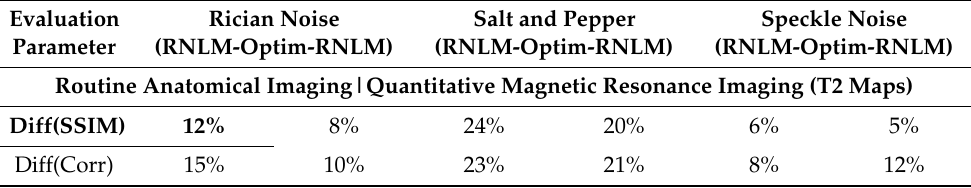
Table 5. A comparison for RNLM filter and proposed optimized variant based on SSIM and correla- tion difference for routine anatomical imaging and quantitative Magnetic Resonance Imaging (T2 maps) of